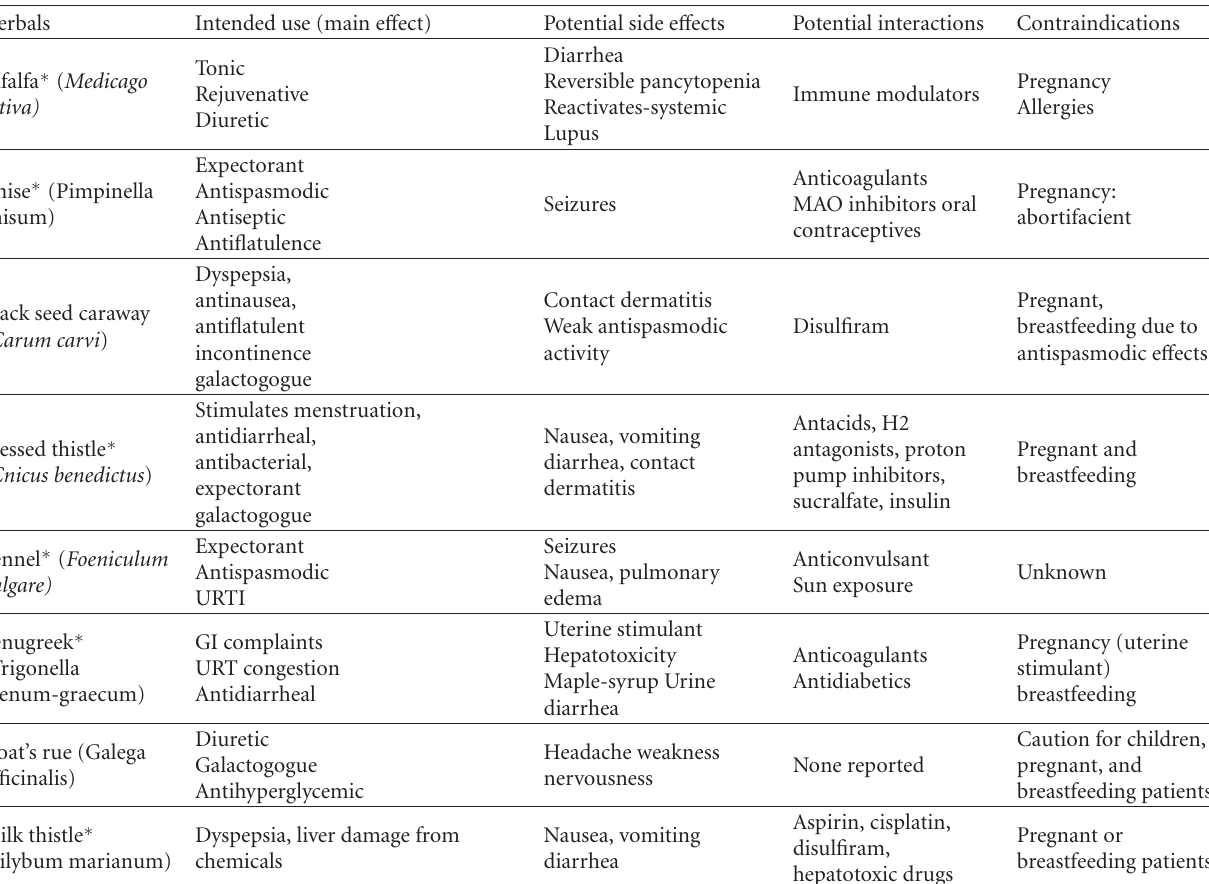
Table 2: Herbs commonly associated with galactogogue properties and known interactions.